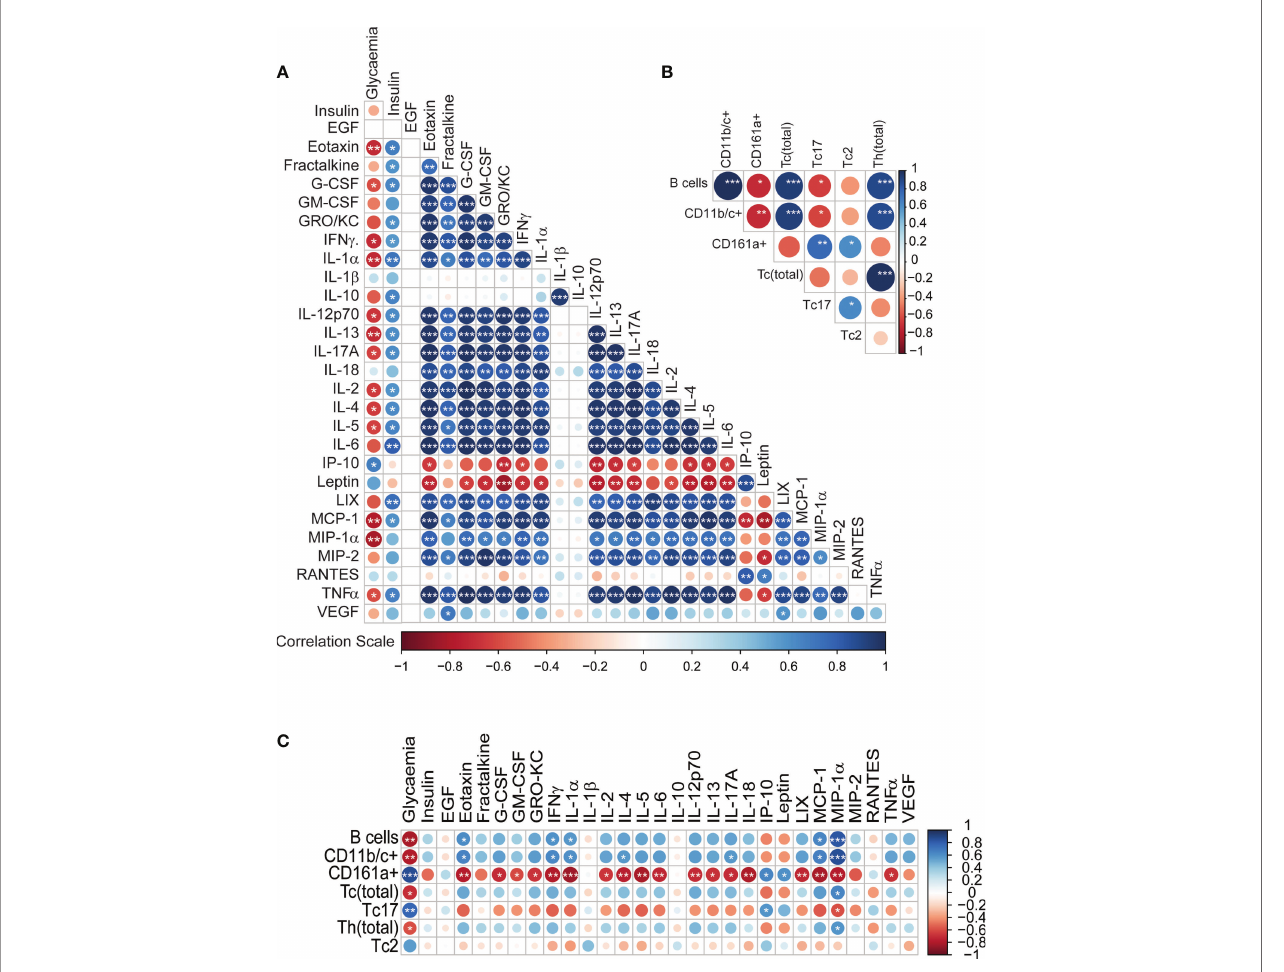
FIGURE 3 | Integrative correlation analysis of the different immune parameters, (A) Cytokine-cytokine (B) Immune cell-immune cell (C) Cytokine-immune cells. The sizes of the circles indicate the strength of association (Pearson ’ s r 2 ), while the colours show negative (red) or positive (blue) correlation. p < 0.001, p < 0.01 and p < 0.05 are re fl ected by ***, ** and *